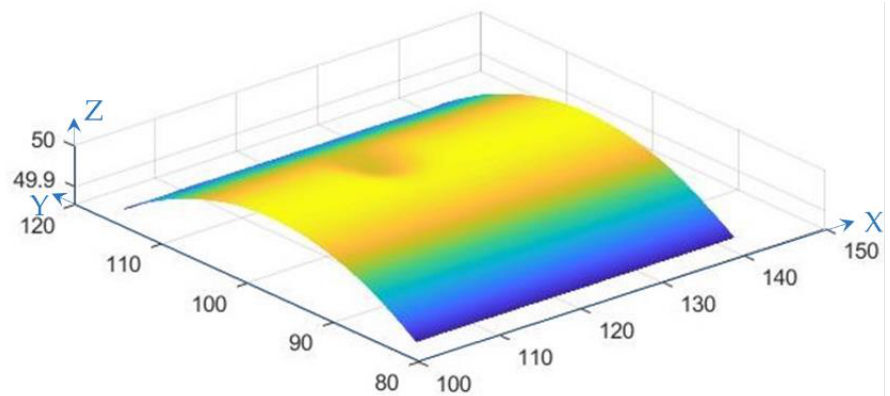
Figure 6. Gaussian smoothing result for the simulated data (m).